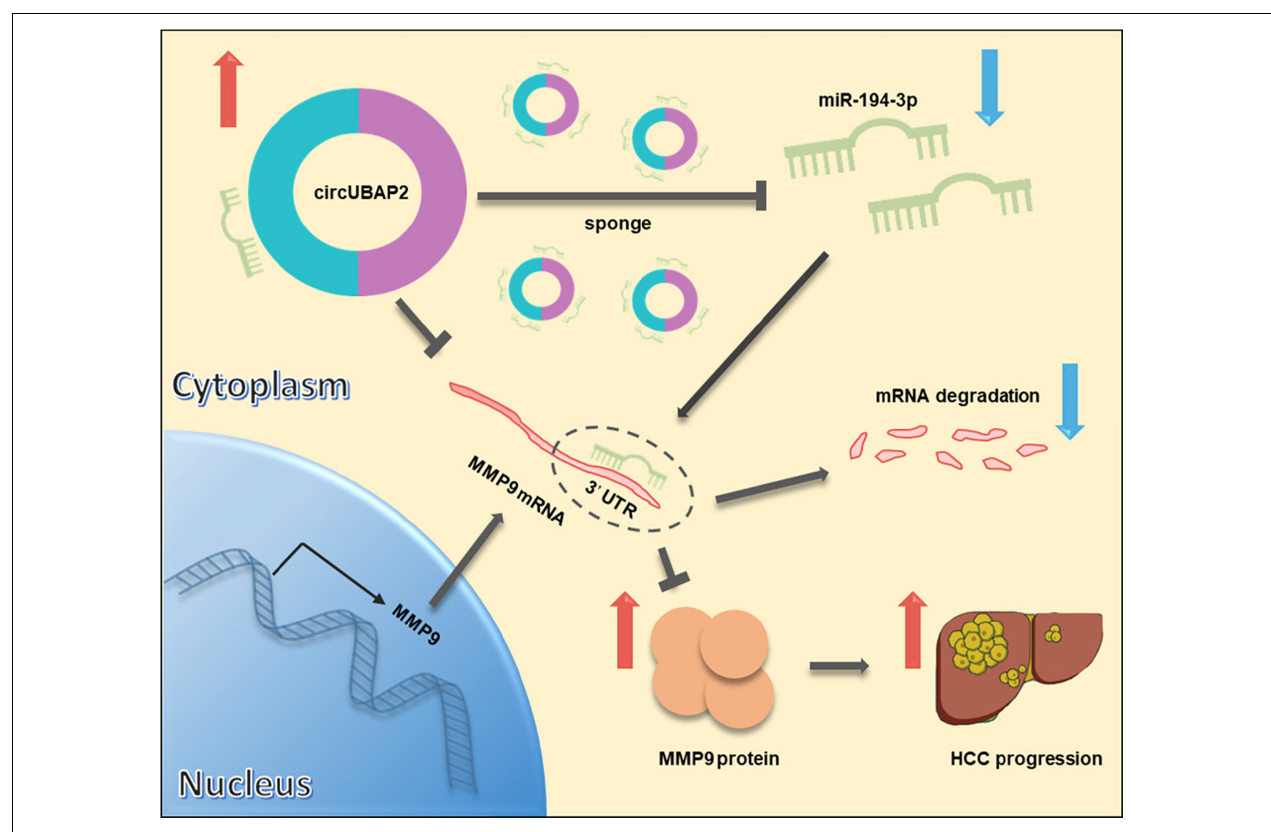
FIGURE 7 | Schematic diagram of the mechanism and function of circUBAP2 in HCC progression. CircUBAP2 promotes the development and progression of HCC through the circUBAP2-miR-194-3p-MMP9